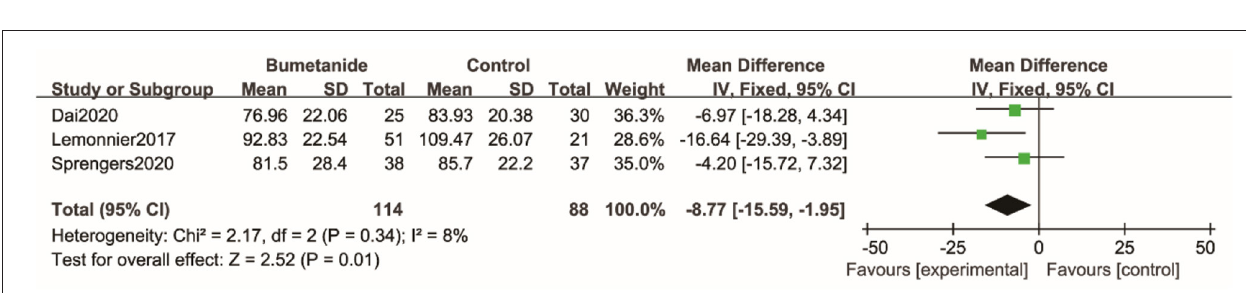
FIGURE 3 | Forest plot of the efficacy of bumetanide on CARS in children with ASD.